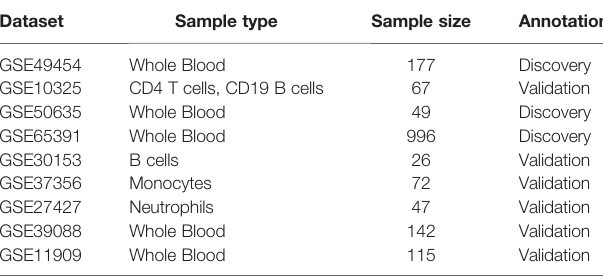
TABLE 1 | Demographic of the study population in discovery and validation dataset.